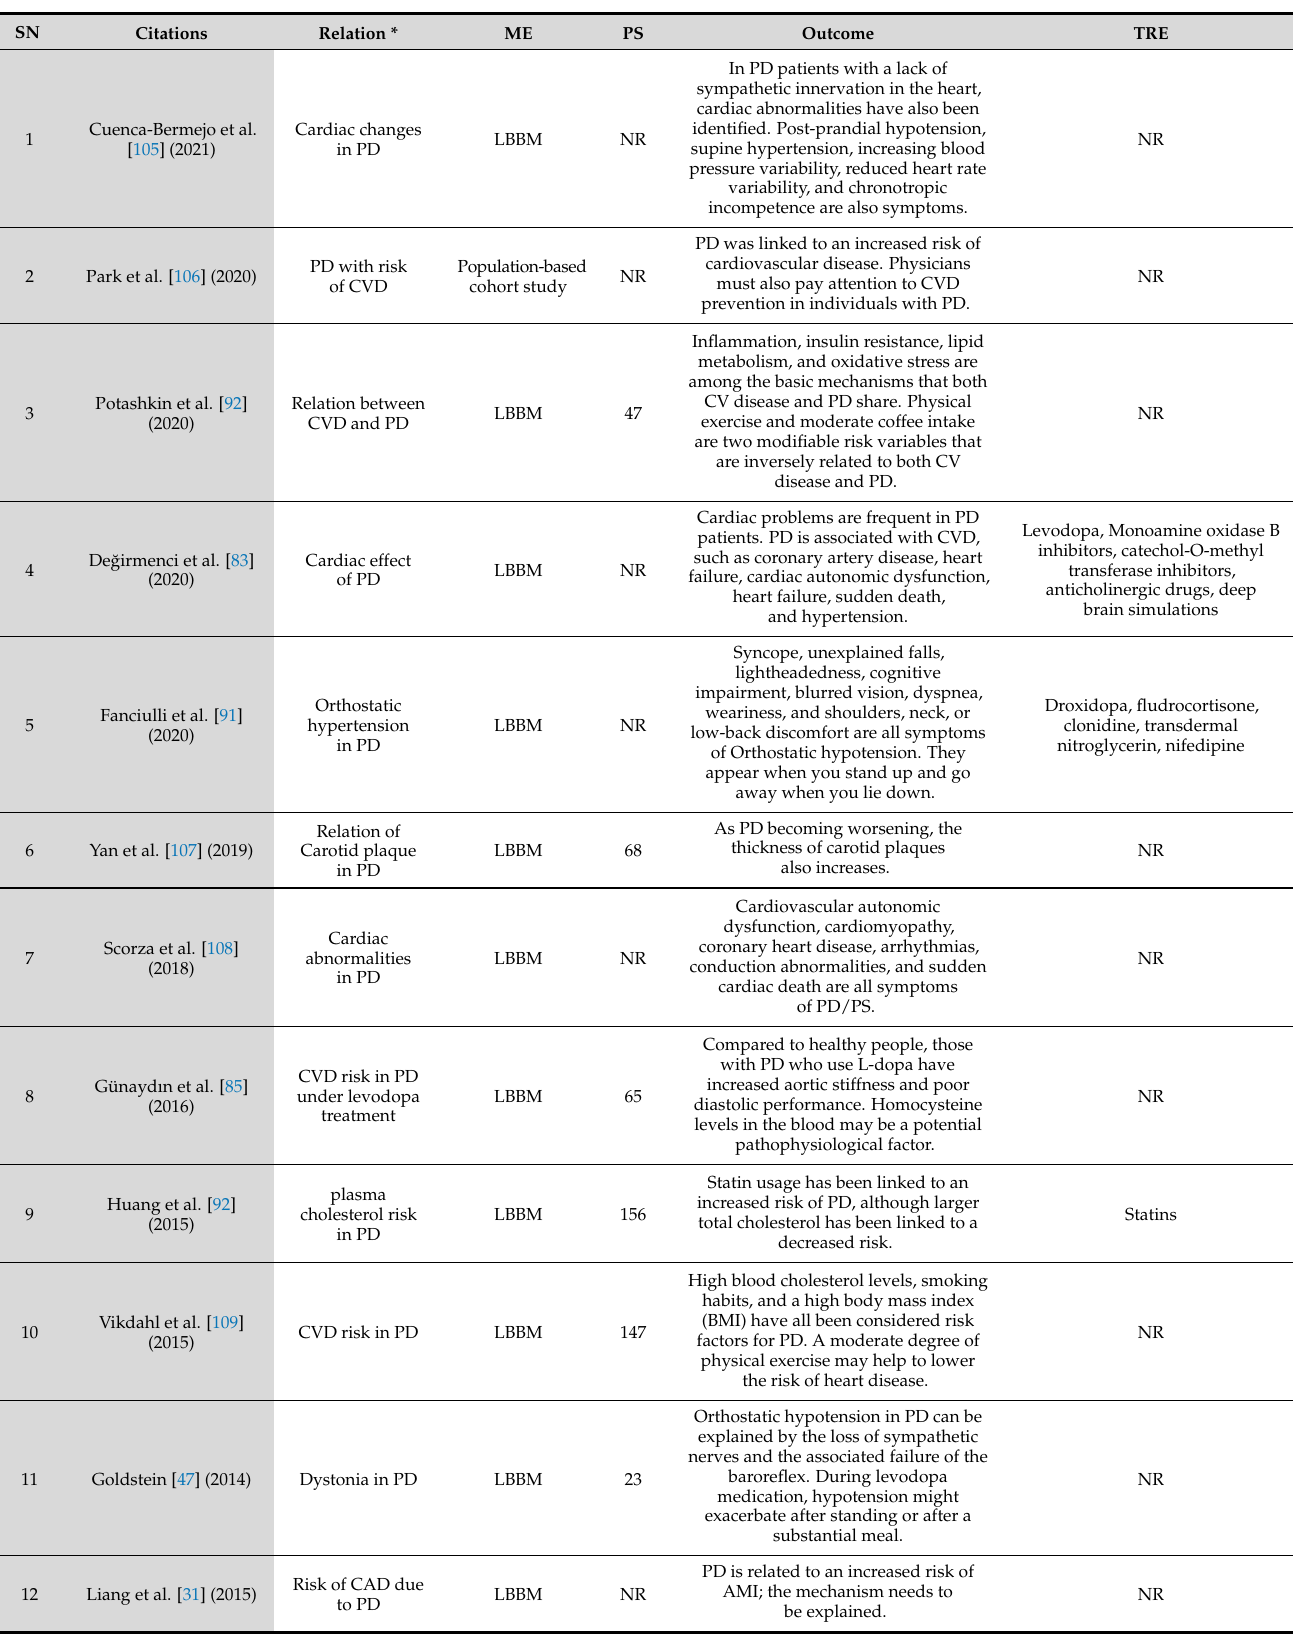
Table 1. The studies show the relation between Parkinson’s and Cardiovascular disease.